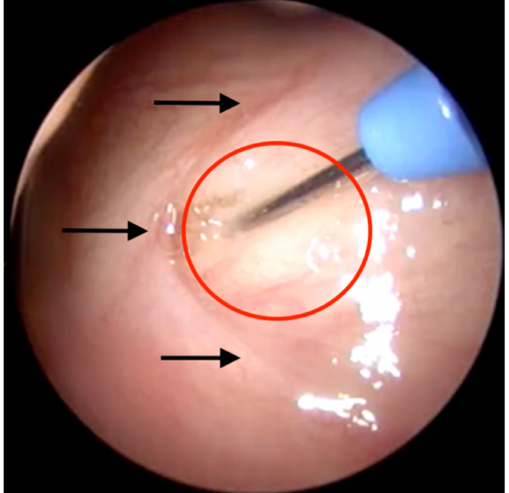
Figure 2. Endoscopic view of the pharyngeal orifice of the ET. The cannula is inserted in the target area (marked in red) in front of the crescent-shaped ET orifice (black